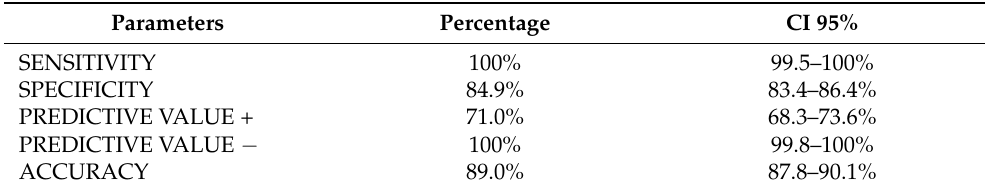
Table 6. Overall predictive values.